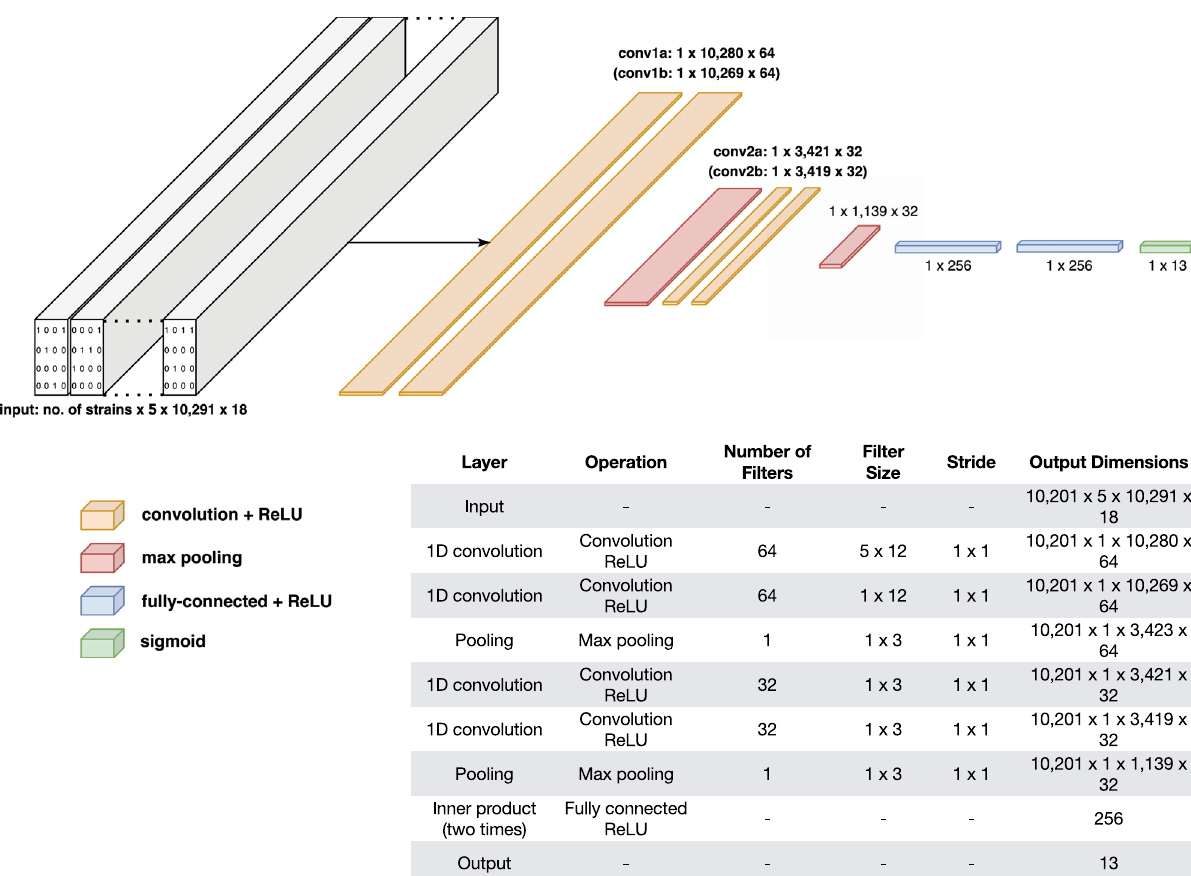
Fig. 1 Schematic diagram and table of the multi-drug convolutional neural network (MD-CNN). In the output layer, each of the 13 nodes is composed of a sigmoid function to compute a probability of resistance for their respective anti-TB drug (13 anti-TB drugs in total). The input consists of 10,201 isolates (TB strains) for which there is resistance phenotype data for at least 1 anti-TB drug; 5 for one-hot encoding of each nucleotide (5 dimensions, one for each nucleotide — adenine, thymine, guanine, cytosine –– plus a gap character); 10,291 being the number of nucleotides of the longest locus ( embC-embA-embB ); 18 loci of interest are incorporated as detailed in the “ Methods ”